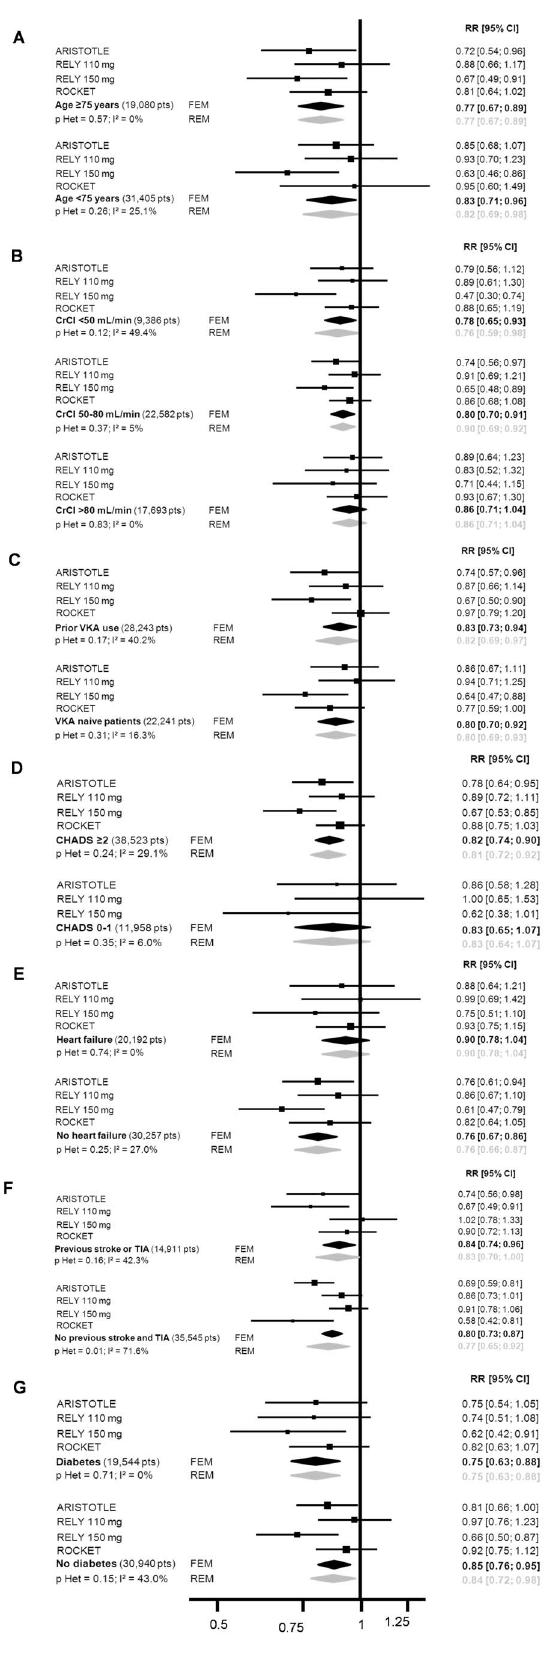
Figure 3. Detailed forest plot of stroke and systemic embolism according to (A) age, (B) renal function, (C) prior VKA exposure, (D) CHADS 2 score, (E) heart failure, (F) prior stroke or transient ischemic attack, (G) diabetes